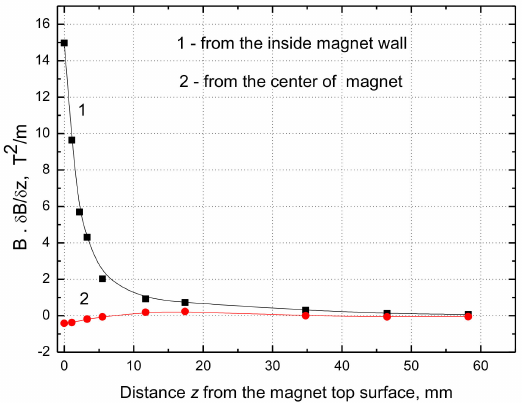
Figure 8. Changes of MF in the perpendicular direction z from the water surface. Curve 1—from the magnet inside wall and curve 2—from the center of the magnet.